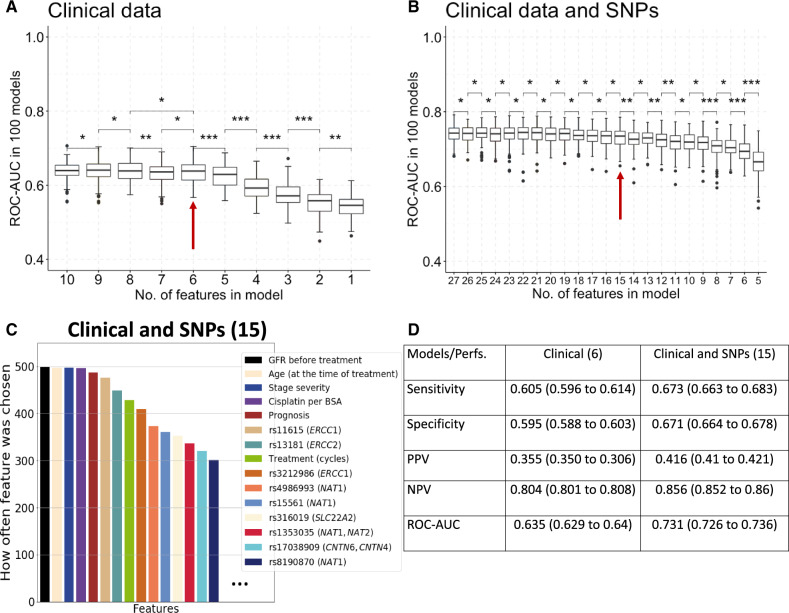
Feature selection using random forest-recursive feature elimination algorithm and diagnostic performances. A and B) Boxplots with different number of features, −10 to 1 and 27 to 5, for clinical and clinical plus genomics, respectively, and respective area under the receiver operating characteristic curve (ROC-AUC) throughout 100 different replications for data shuffling. Asterisks between boxplots represent P values (paired t test) of >.05 (*), ≤.05 (**), and ≤.01 (***). All tests were 2-sided. The red arrow represents the block chosen for further analysis. C) The features chosen the most on the 15-features clinical and SNP-based models. D) Performances obtained (mean and 95% confidence intervals) on the clinical models (6 features) and on the clinical and SNP-based models (15 features) using 0.50 cutoff for classification for sensitivity, specificity, positive predictive value, and negative predictive value. NPV = negative predictive value; Perfs. = performances; PPV = positive predictive value; ROC-AUC = area under the receiver operating characteristic curve; SNP = single-nucleotide polymorphism.